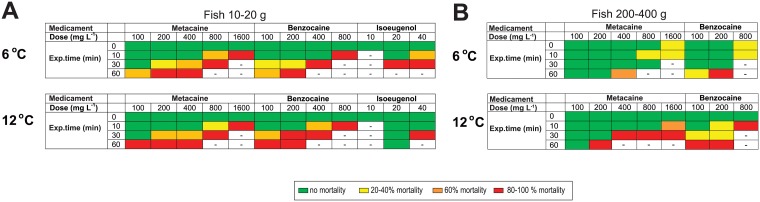
Therapeutic windows and conditions for lethal conditions.Therapeutic window for different anaesthetic concentrations and exposure times in different anaesthetic solutions (A) Effect of metacaine, benzocaine and isoeugenol on small fish (10–20 g) at 6°C (upper panel) and 12°C (lower panel). (B) Effect of metacaine and benzocaine on medium sized fish (200–400 g) at 6°C (upper panel) and 12°C (lower panel). Percentage mortality is indicated by colors: green = no mortality, yellow = 20–40% mortality, orange = 60% mortality, red = 80–100% mortality. N = 5.